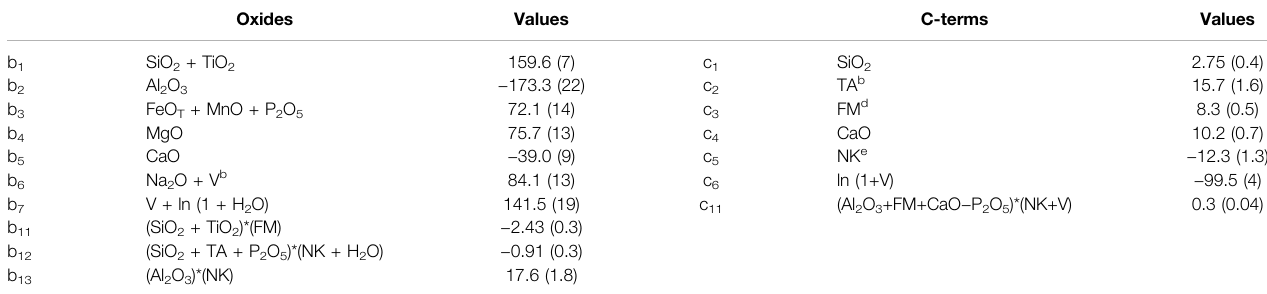
TABLE 2 | Coef fi cients for calculation of VFT parameters B and C [A = − 4.55 (± 0.21) a ] from melt compositions expressed as mol% oxides (Giordano et al., 2008).